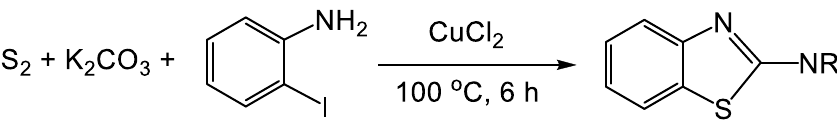
Figure 31. Formation of 2-N-substituted benzothiazoles via initial dithiocarbamate formation.